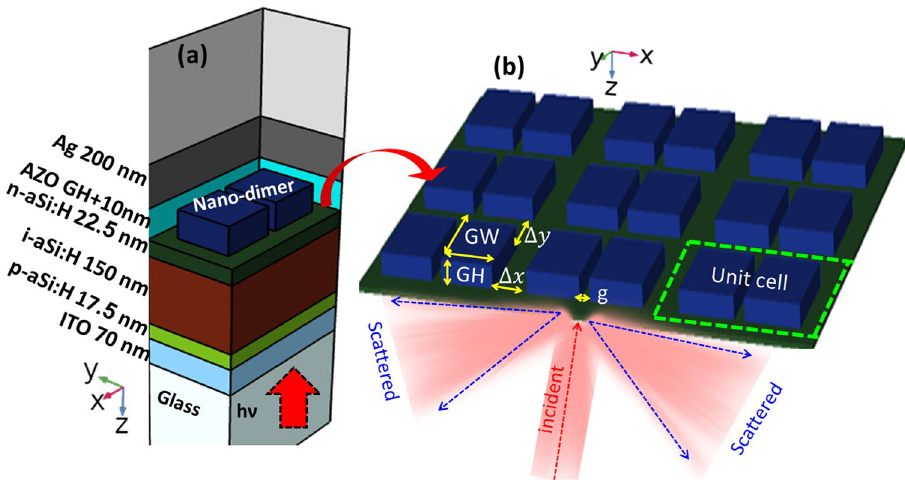
Figure 1. ( a ) Geometrical arrangement of the layers of an ultra-thin-film aSi:H solar cell. ( b ) Geometrical parametrization of the nano-dimer metasurface. Both 3D plots in a,b were generated using the COMSOL